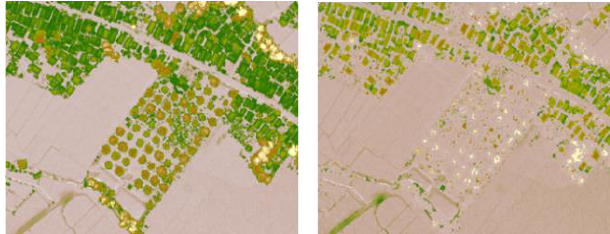
Figure 4b. TRI threshold eliminated tree features.